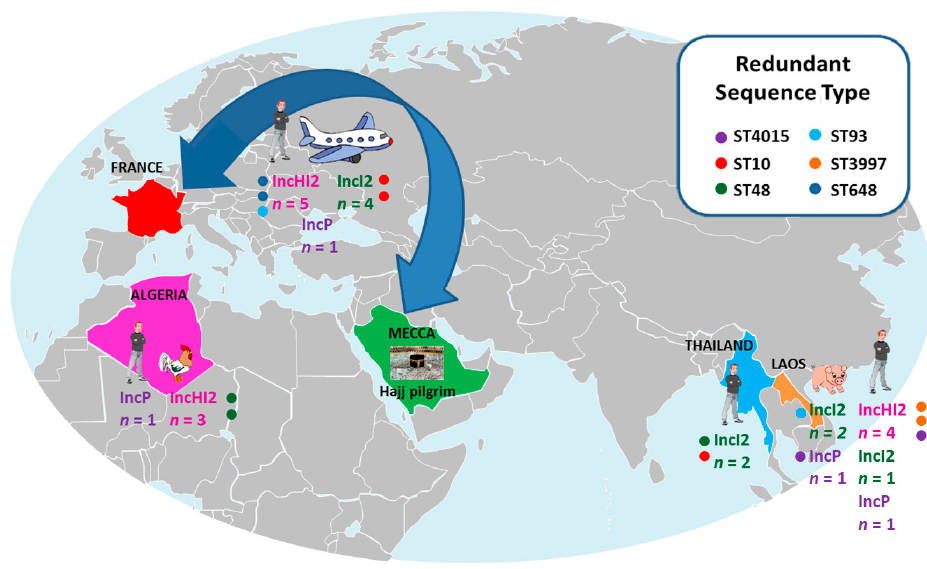
Figure 1. Origins and plasmid type of mcr-1 strains collected in our study.